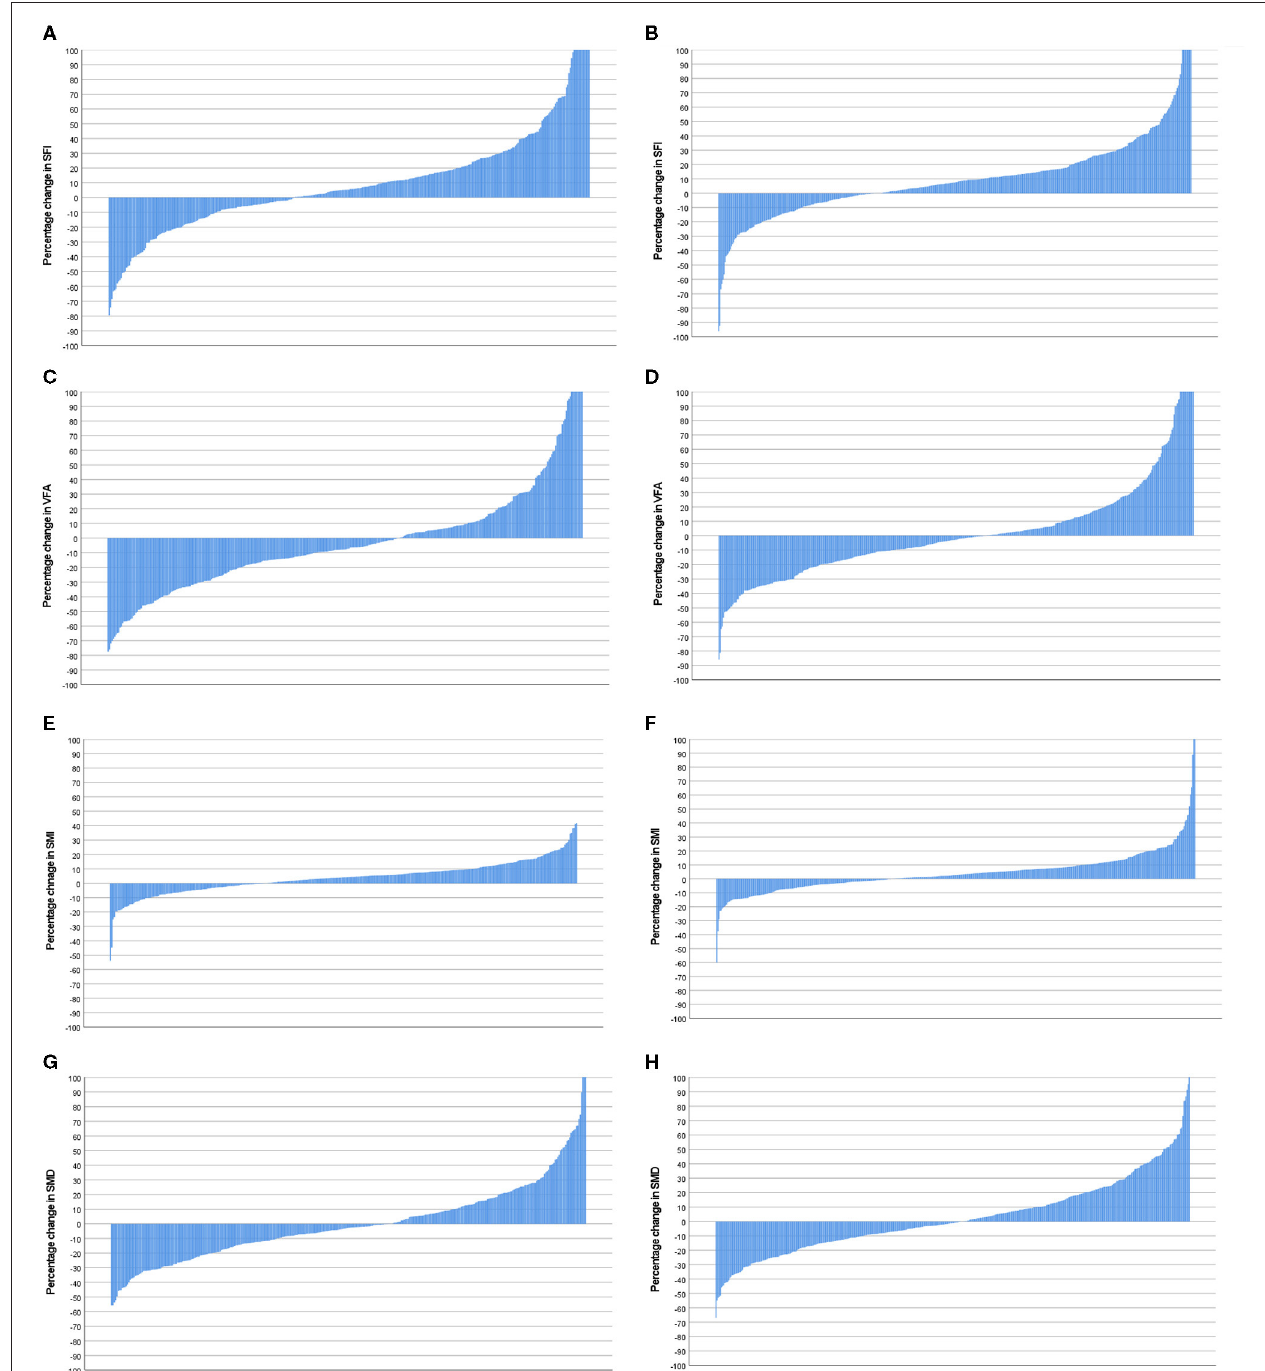
FIGURE 6 | (A) Percentage change in SFI in female patients ( n = 359). (B) Percentage change in SFI in male patients ( n = 445). Comparison of percentage change in SFI in female ( n = 359) and male ( n = 445) patients ( p = 0.380). (C) Percentage change in VFA in female patients ( n = 359). (D) Percentage change in VFA in male patients ( n = 445). Comparison of percentage change in VFA in female ( n = 359) and male ( n = 445) patients ( p = 0.04). (E) Percentage change in SMI in female patients ( n = 359). (F) Percentage change in SMI in male patients ( n = 445). Comparison of percentage change in SMI in female ( n = 359) and male ( n = 445) patients ( p = 0.324). (G) Percentage change in SMD in female patients ( n = 359). (H) Percentage change in SMD in male patients ( n = 445). Comparison of percentage change in SFD in female ( n = 359) and male ( n = 445) patients ( p = 0.089).